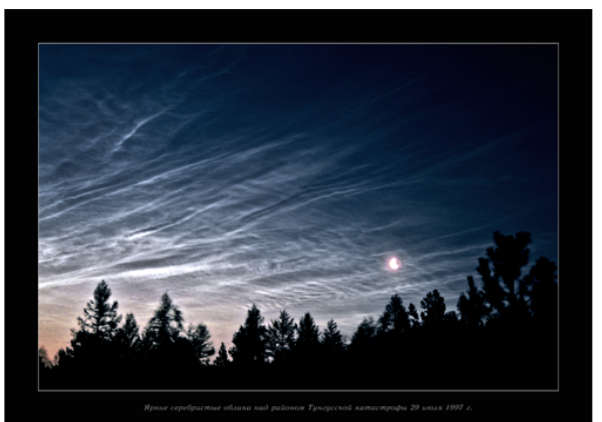
Figure 1. “ And serene Moon – majestic swan, Is swimming through the silvery clouds .” Photographed by V. Romejko on 29 July 1997, Tunguska region in Siberia, latitude is 60.9 ◦ N.